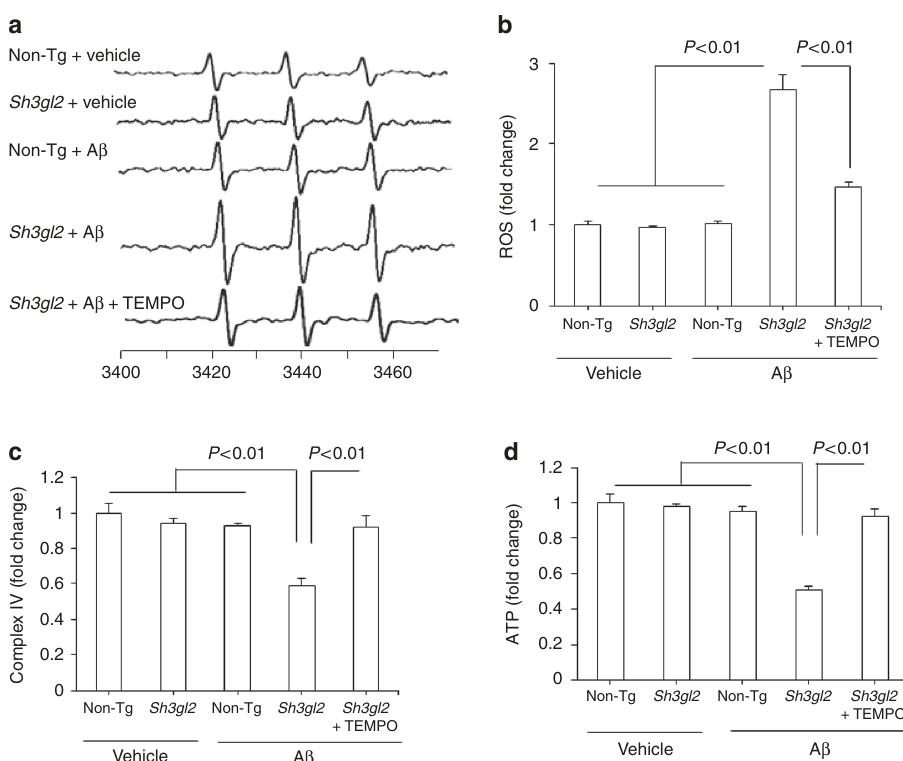
Fig. 5 Effect of mitochondrial ROS scavenger on EP/A β -mediated p38 activation, ROS production, and mitochondrial dysfunction. a Brain slices from 3- month-old non-Tg or Tg Sh3gl2 mice were perfused with A β (50 nM) for 1 h with/without pretreatment of mitochondrial antioxidant MitoTEMPO (TEMPO, 1 µ M) for 5 min, and then subjected to measure EPR, mitochondrial complex IV activity, and ATP levels. a Representative spectrum of EPR in non-Tg and Tg Sh3gl2 brain slices with the treatment of vehicle or A β in the presence of MitoTEMPO. b Quanti fi cation of EPR spectra in the indicated groups of mice. c , d Mitochondrial complex IV activity ( c ) and ATP levels ( d ) in the indicated groups of brain slices treated with vehicle or A β in the presence/absence of MitoTEMPO. Data are expressed as fold change relative to non-Tg vehicle control group. Date are shown as mean ± s.e.m., n = 3 per group (one-way ANOVA in b – d